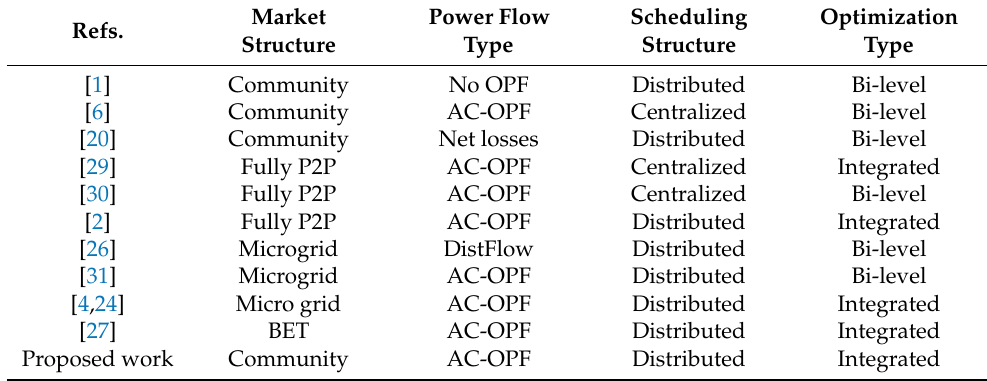
Table 1. Literature review on related works.